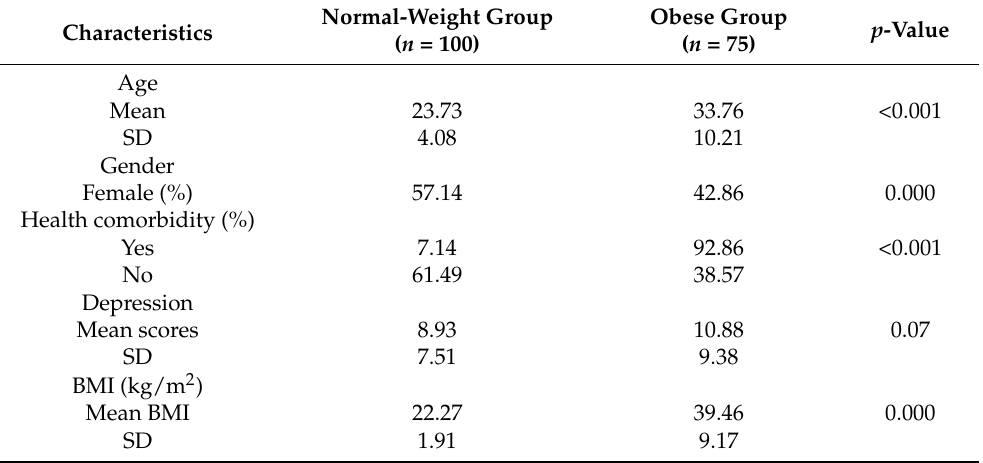
Table 1. Descriptive data of the study